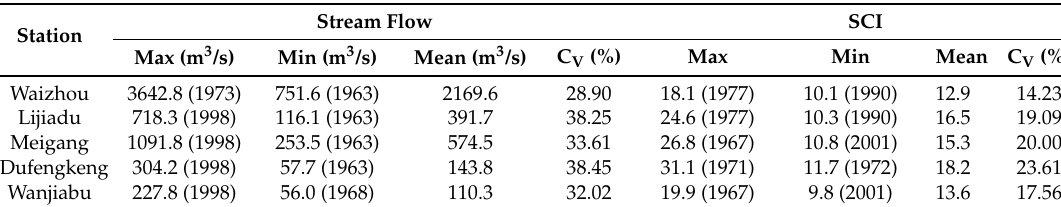
Table 2. Descriptive statistics of the annual stream flow at the five stations in the Poyang Lake Basin.